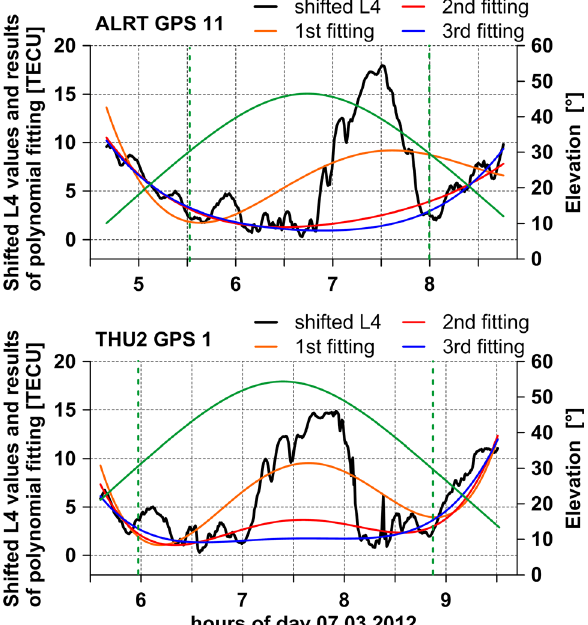
Fig. 2. Background TEC estimation using iterative polynomial fi tting for satellite GPS 11, station ALRT (top panel) and satellite GPS 1, station THU2 (bottom panel). Green line corresponds to elevation of satellites and applied cut-off angle (30 (cid:3)